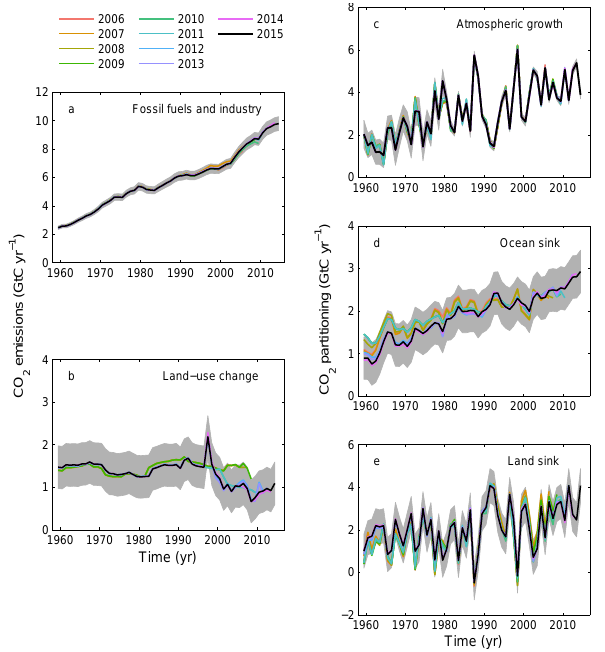
Figure 9. Comparison of global carbon budget components released annually by GCP since 2006. CO 2 emissions from both (a) fossil fuels and industry ( E FF ) and (b) land-use change ( E LUC ), as well as their partitioning among (c) the atmosphere ( G ATM ), (d) the ocean ( S OCEAN ), and (e) the land ( S LAND ). See legend for the corresponding years, with the 2006 carbon budget from Raupach et al. (2007), 2007 from Canadell et al. (2007), 2008 released online only, 2009 from Le Quéré et al. (2009), 2010 from Friedlingstein et al. (2010), 2011 from Peters et al. (2012b), 2012 from Le Quéré et al. (2013), 2013 from Le Quéré et al. (2014), and 2014 from Le Quéré et al. (2015) and this year’s budget (2015; this study). The budget year generally corresponds to the year when the budget was first released. All values are in GtCyr − 1